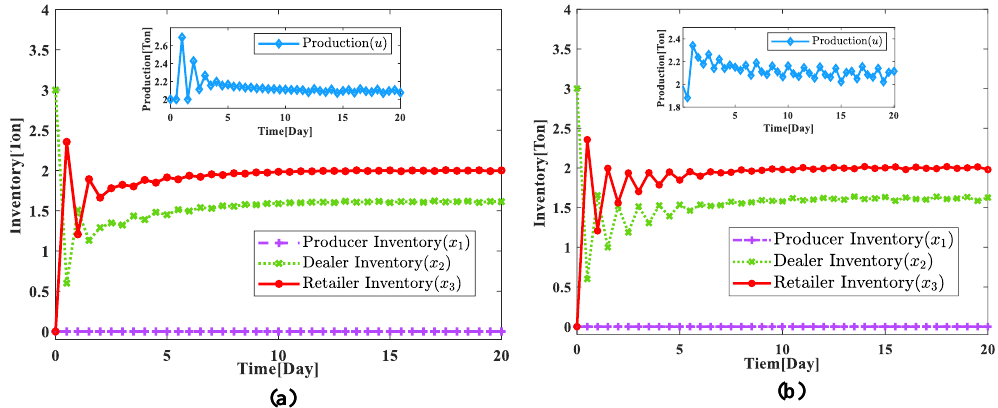
Figure 10. Comparison of supply chain system inventory for different simulation conditions under normal conditions. ( a ) Improved adaptive sliding mode control; ( b ) traditional sliding mode control.